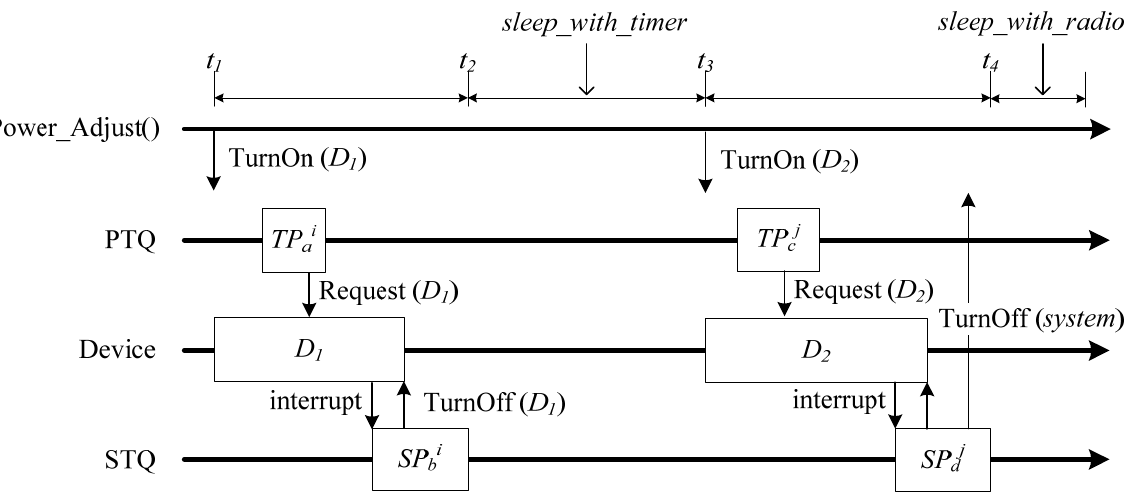
Figure 4. Power mode transition scenario using sleep_with_timer and sleep_with_radio .